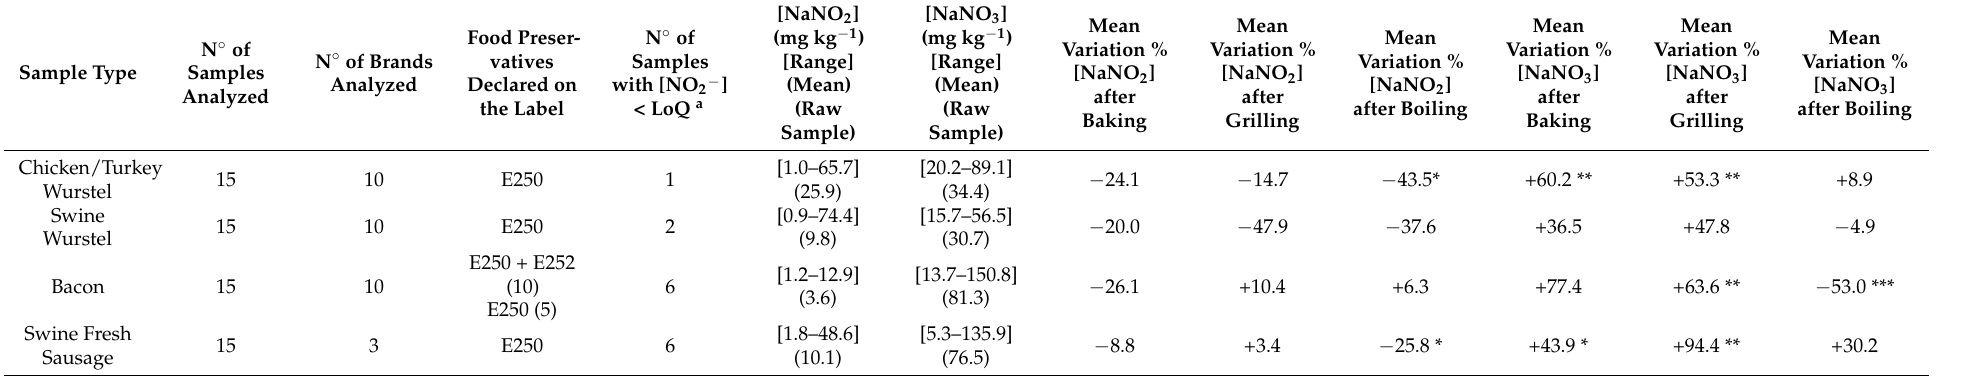
Table 2. Mean variation percentages of nitrite and nitrate concentrations after different types of cooking